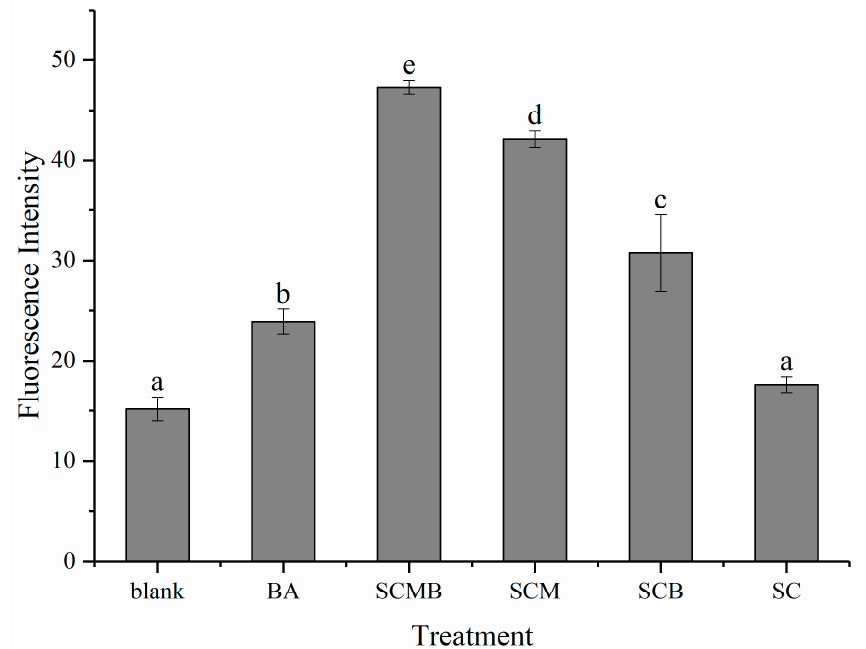
Figure 9. Mitochondrial membrane potential in HepG2 cells by flow cytometry under different treatments. Using different letters in the figure represents significant difference among six different treatments ( p < 0.05).